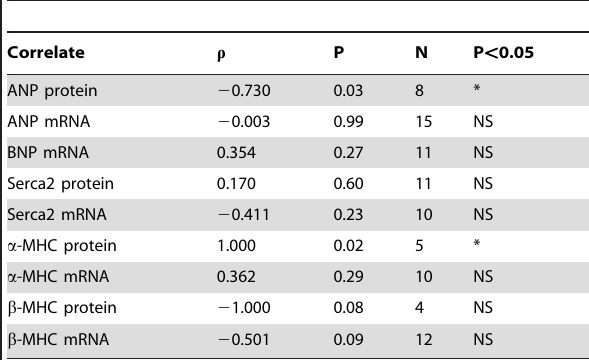
Table 5. Spearman correlations of fetal genes with absolute heart weight. Table 6. Spearman correlations of fetal genes with the